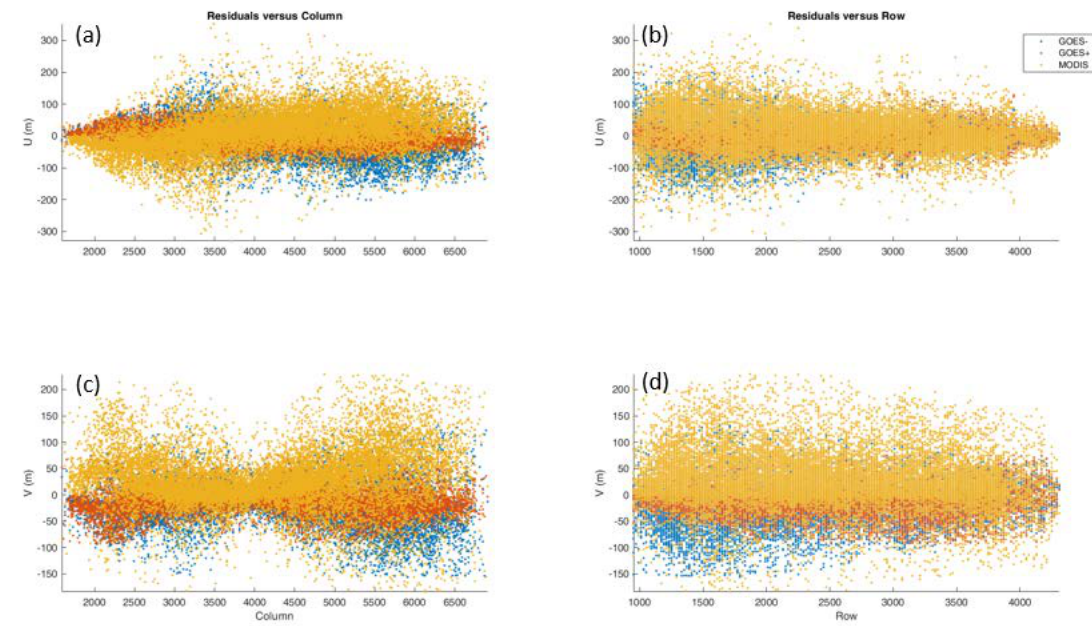
Figure 6. Residual disparities after applying the 3D-winds retrieval model in the tangent plane are plotted by image column in ( a ) and ( c ) or row in ( b ) and ( d ). The legend identifies the matches used in the retrievals: i.e., from GOES ABI T 0 to T 0 − ∆ t (“GOES−“), T 0 + ∆ t (“GOES+“), and MODIS. Residuals are less than 0.5 ABI B02 pixel, which is 500 m at the subsatellite point. The case shown is MODIS granule MOD2018196.1700.061 (MODIS Band 1) paired with GOES-16 CONUS ABI Band 2.